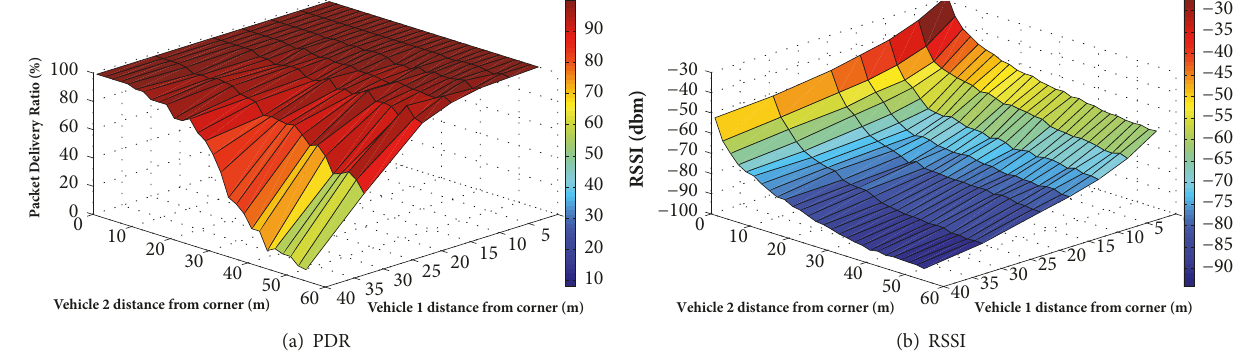
Figure 16: Results from the simulation with 𝛼 = 0.4 for blind corner with small obstruction. (a) PDR. (b) RSSI.